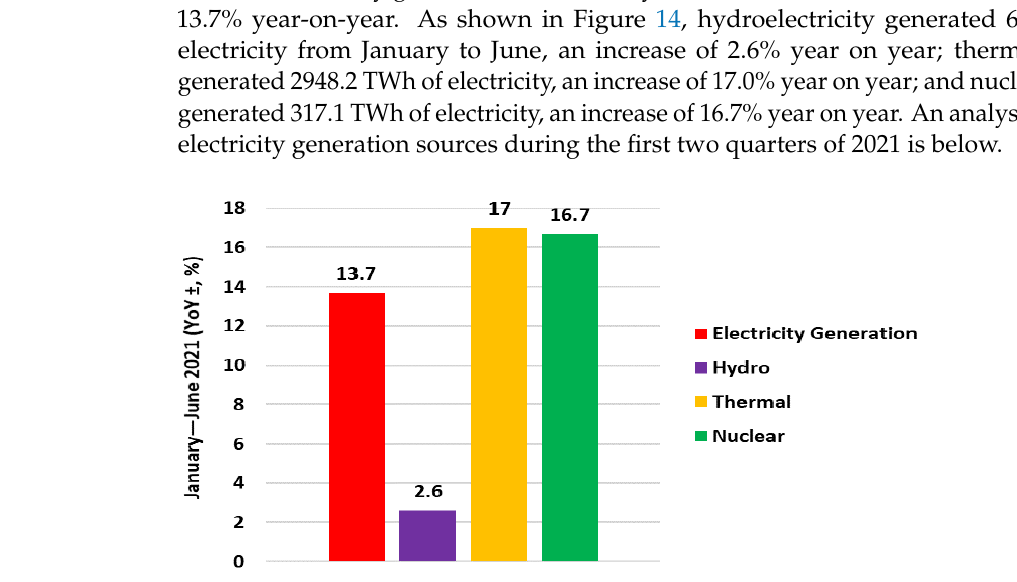
Figure 14. Electricity generation in January–June 2021.